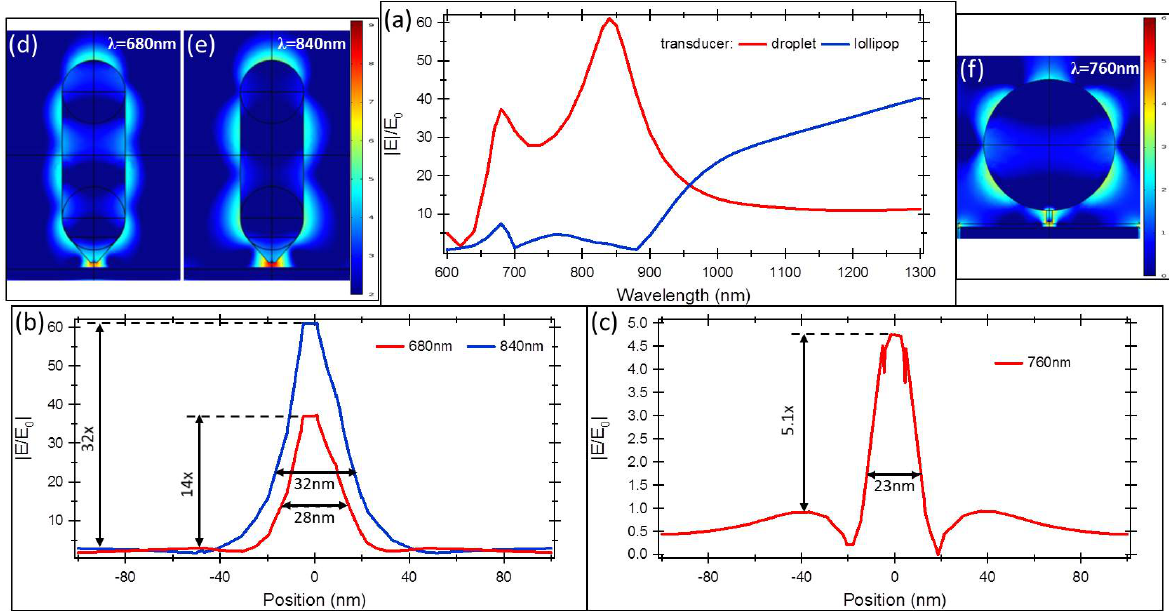
Figure 6: (a) Electric field enhancement at the distance of 7 nm from transducer for droplet and lollipop transducers. (b), (c) Electric field distribution along the width of a droplet transducer through the center at distance of 7 nm from transducer and normalized to E 0 for droplet (b) and lollipop (c) transducers. (d), (e), (f) Electric field profile (logarithmic scale) through a cross-section of the droplet (d), (e) and lollipop (f)